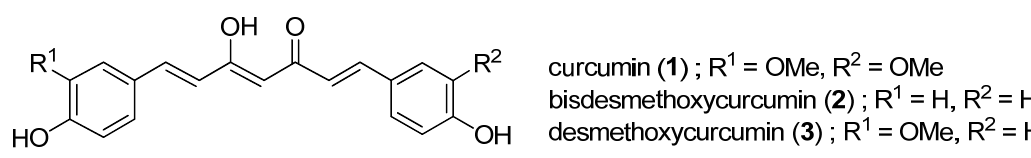
Figure 1. Curcuminoid